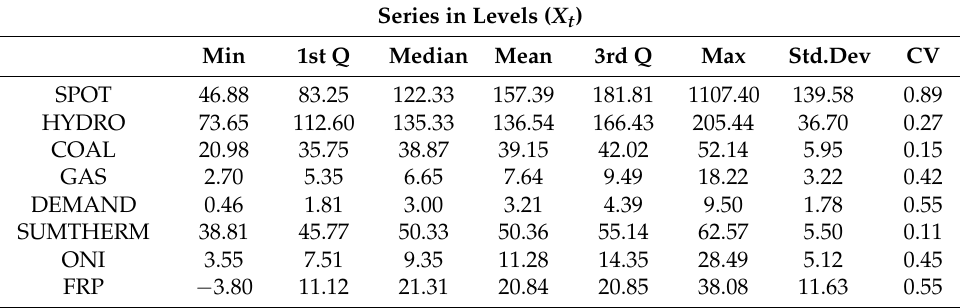
Table 1. Descriptive statistics of the exogenous variables considered in the analysis.